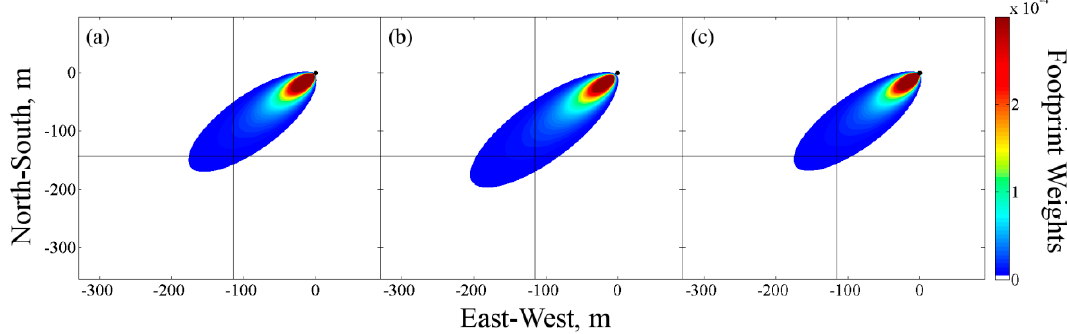
Figure 6. Contour plots of the footprints at EC1 using the (a) S90, (b) H2000, and (c) KM01 models during stable stratification on DOY 218 at 6:30 am USA Central Standard Time (CST).